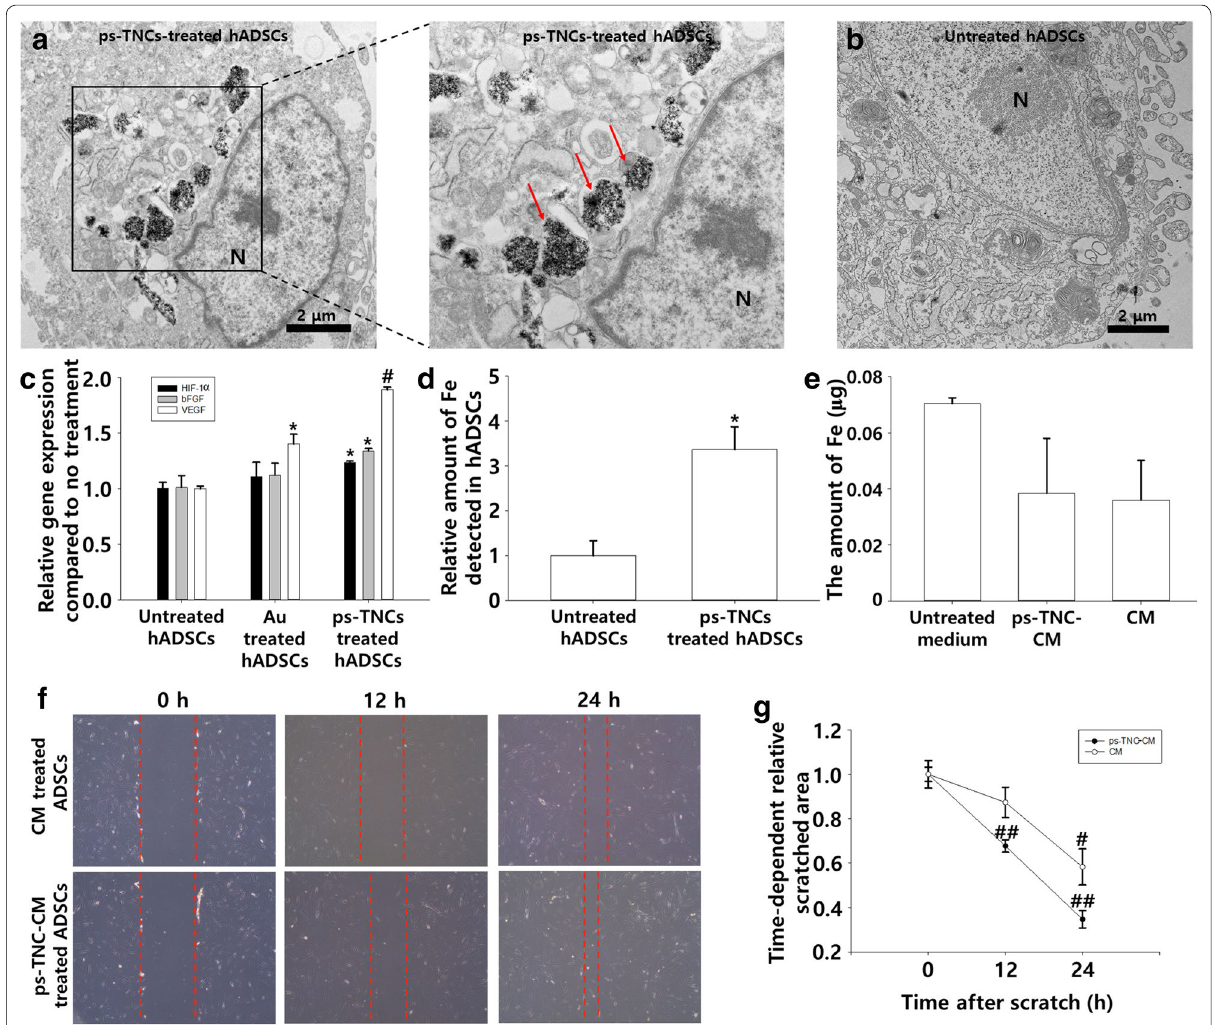
Fig. 4 The effect of endocellularly released iron through endocytosis. TEM image of hADSCs ( a ) with and ( b ) without ps‑TNC treatment (3 µg/ mL, 12 h, N: nucleus, red arrows: ps‑TNCs in endosomes, Scale bars 2 µm). Dash lined box shows the high magnification image in the left side. c = Comparison of HIF-1a , hFGF and VEGF expression in untreated hADSCs, with gold nanoparticles treatment (3 µg/mL, 12 h), and ps‑TNC treatment (3 µg/mL 12 h, n 3, # p < 0.01, * p < 0.05 compared to the untreated group). d Relative amount of iron ion detected in hADSCs after ps‑TNC = treatment as quantified by ICP‑OES (n 5, * p < 0.01 compared to the untreated group). e The amount of iron ion detected in various media as = quantified by ICP‑OES (n 4). f , g The migration of hADSCs treated with CM or ps‑TNC‑CM for 24 h (n 4, # p < 0.01, ## p < 0.001 compared to 0 h of = = each